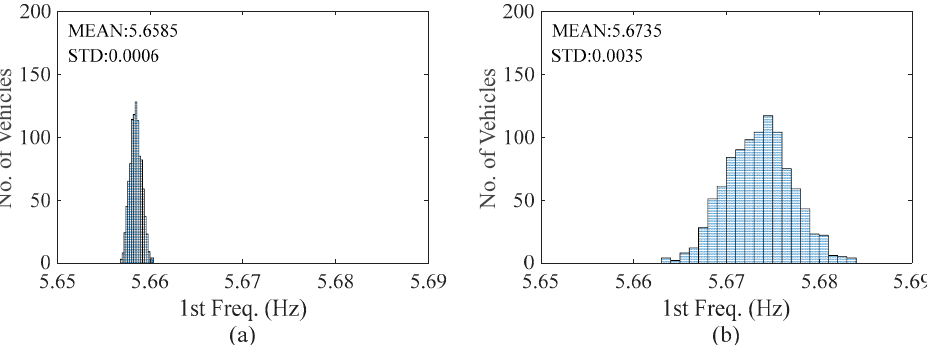
Figure 4. No. vehicles versus bridge eigenfrequencies associated with the 1st axle located at: ( a ) 3 m and ( b ) 9 m, from 1st support.